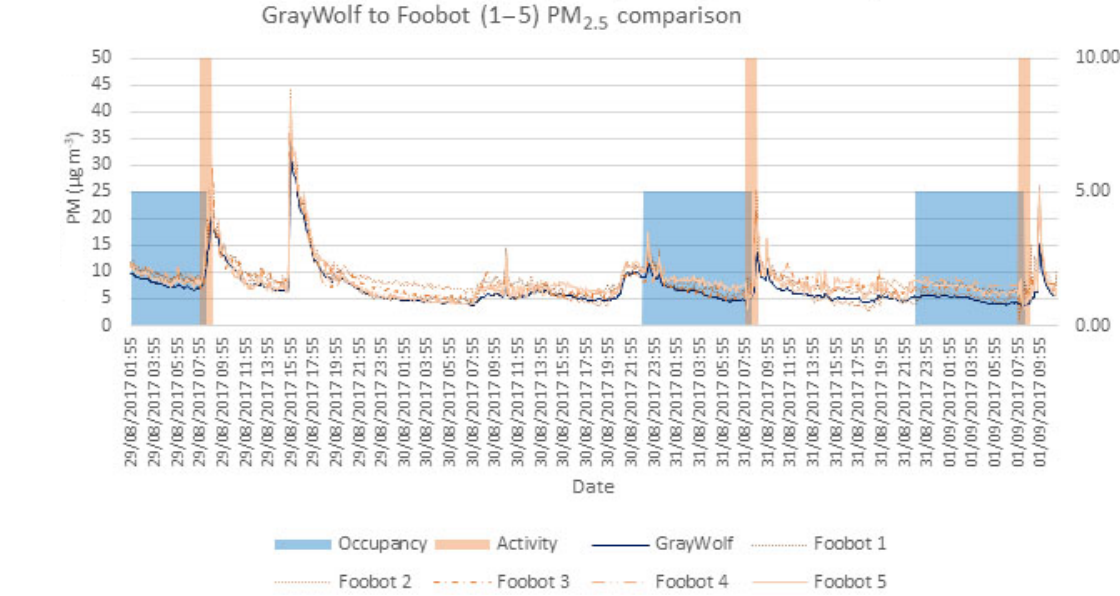
Figure 7. PM 2 . 5 levels from 29 August to 1 September 2017 form the Foobot and GrayWolf instruments. (Activity describes the morning routine: showering, grooming, and changing.) Table 6. Summary statistics for the generated t VOC from the validation dataset divided by instruments. Instrument t VOC mean t VOC min. t VOC max. % time (ppb) (ppb) (ppb) >300ppb GrayWolf TG-502 TVOC 176.4 143 549 0.82% Generated Foobot A 172.97